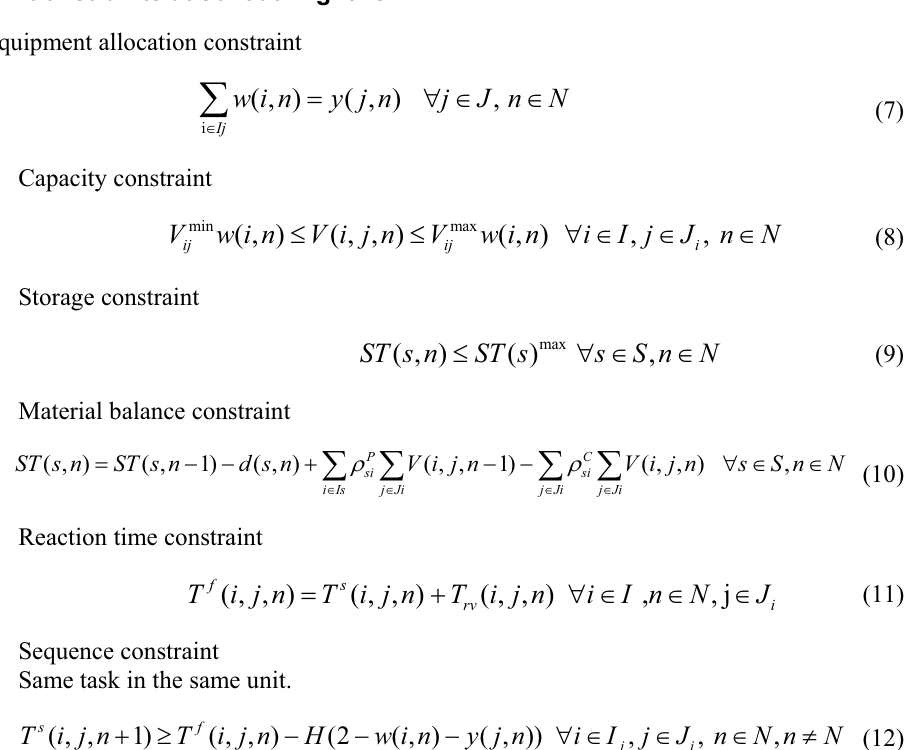
T of the integration model. These i